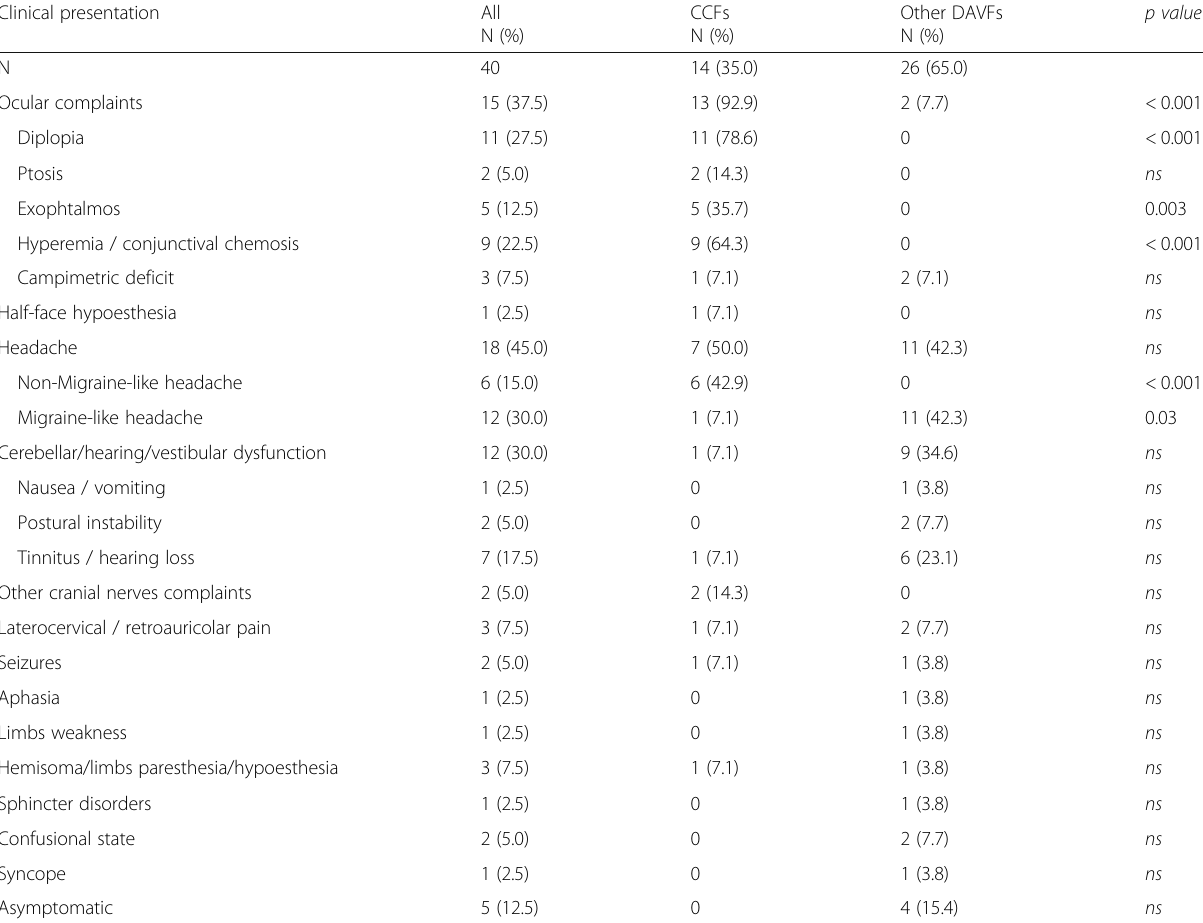
Table 2 Symptoms in relation to the type of DAVFs Clinical